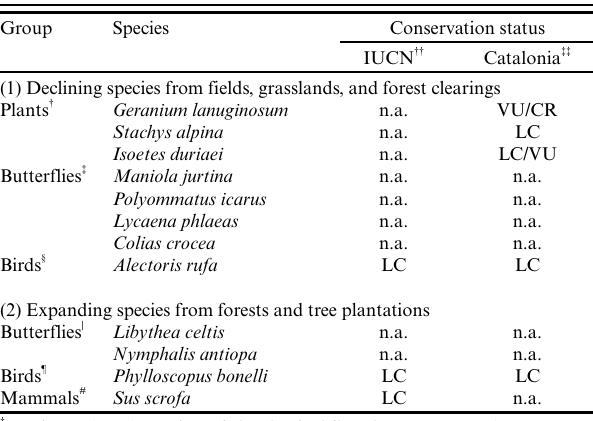
Table 3 . List of selected bioindicator species. Population dynamics were (1) negatively affected by the regression of open habitats, and (2) positively affected by the expansion of forests and tree plantations.